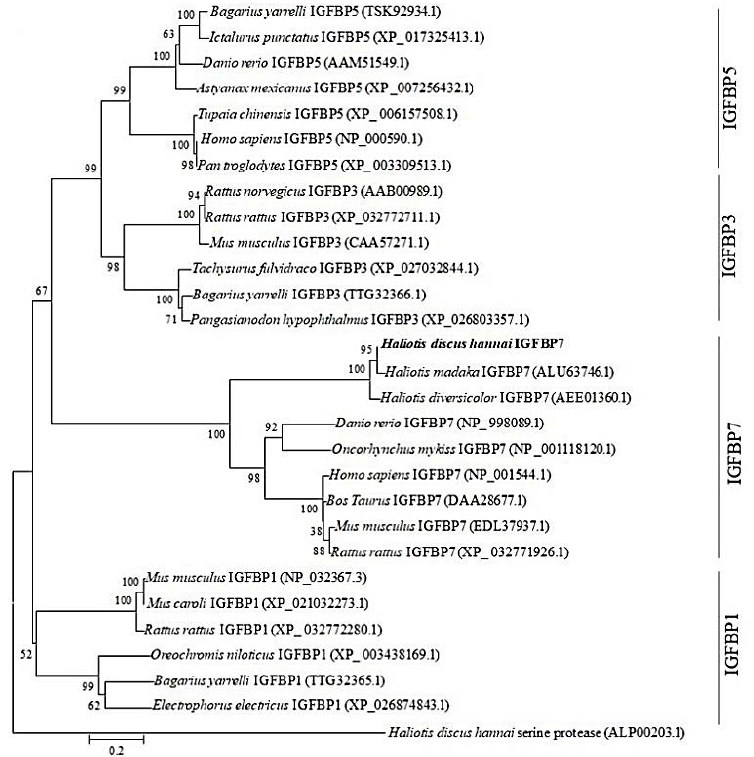
Figure 4. Phylogenetic tree based on amino acid sequences of IGFBPs from vertebrates and invertebrates. Evolutionary analysis was performed using a neighbor-joining method with 1000 bootstrap replicates. The scale bar represents the number of amino acid substitutions per site. All sequences were retrieved from the GenBank of NCBI. GenBank accession numbers are shown in parentheses. Hdh IGFBP7 is highlighted in bold